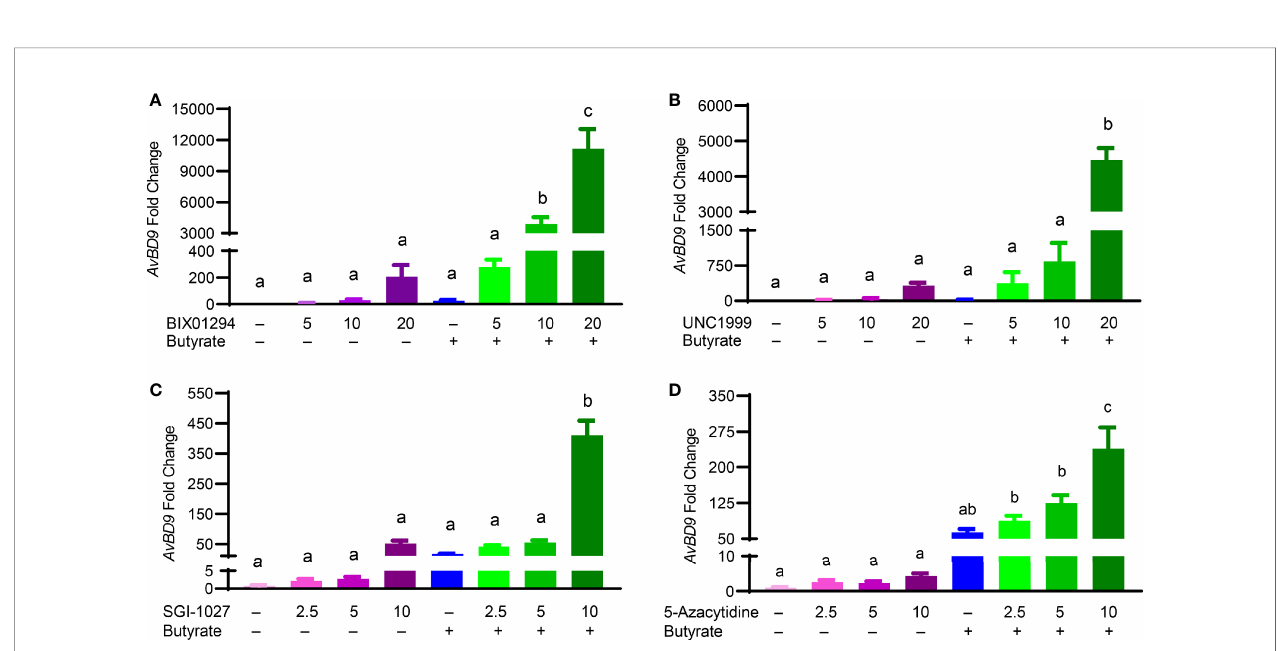
FIGURE 4 | Synergistic induction of the AvBD9 mRNA expression in HTC cells between HMTi and butyrate or between DNMTi and butyrate. Chicken HTC cells were stimulated in duplicate with indicated concentrations ( m M) of BIX01294 (A) , UNC1999 (B) , SGI-1027 (C) , or 5-azacytidine (D) individually or in combination with 2 mM butyrate for 24 h, followed by RT-qPCR analysis of AvBD9 mRNA expression. Results are shown as means ± SEM of three independent experiments. The bars not sharing a common superscript are considered signi fi cantly different ( P < 0.05) based on one-way analysis of variance and post hoc Tukey ’ s